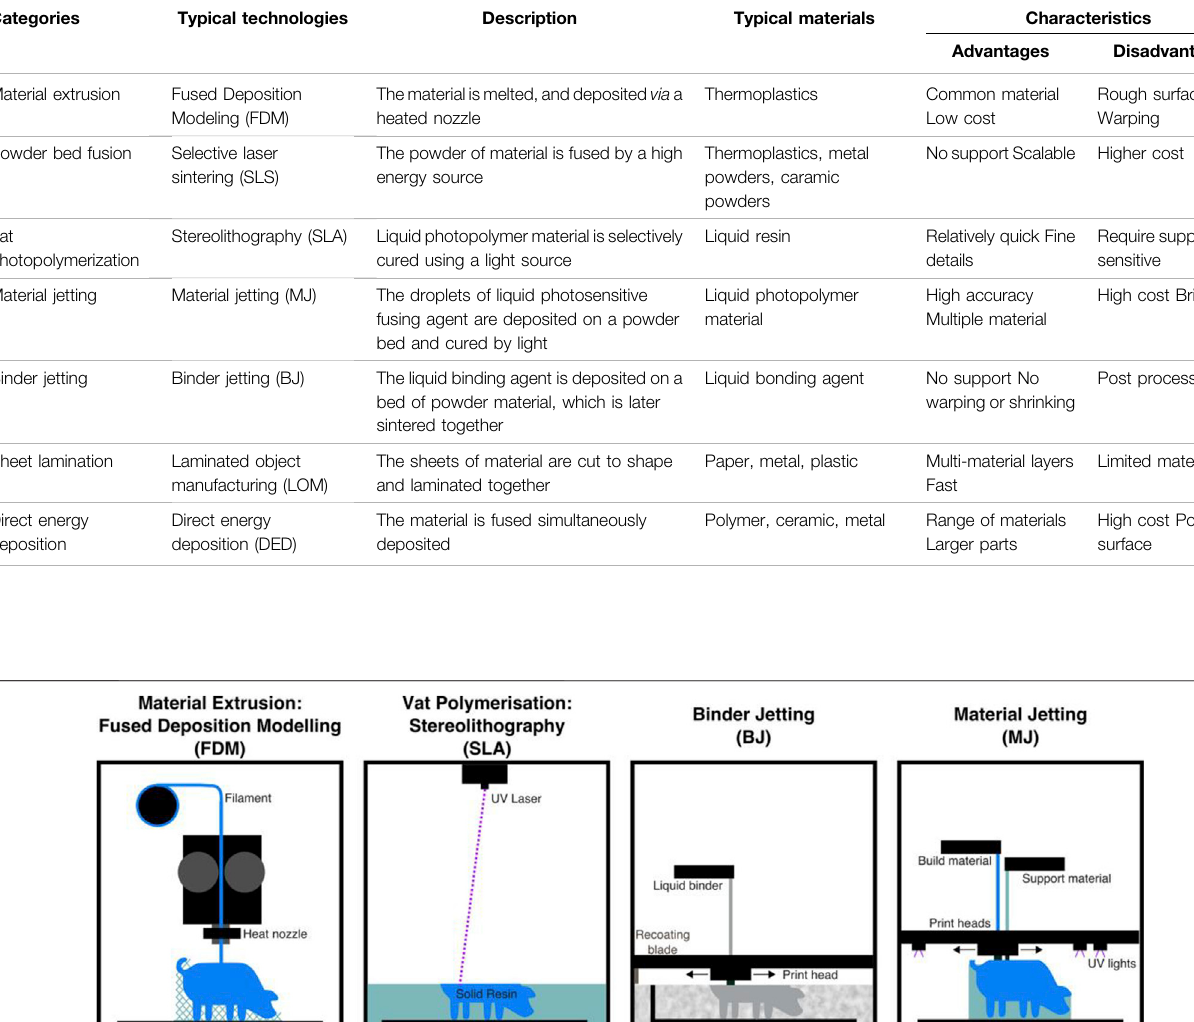
Frontiers in Bioengineering and Biotechnology |